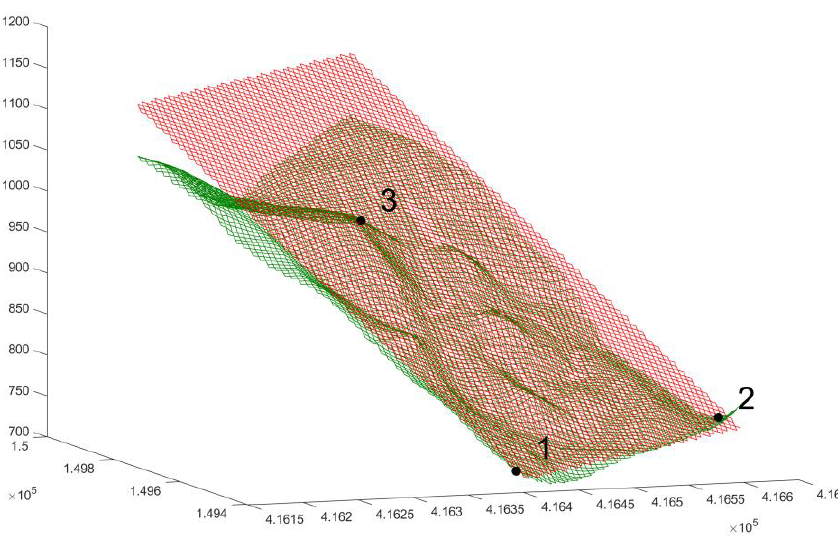
Figure 6. The plane DEM (in red) of the case study above the NDTM (in green) with the reference points.